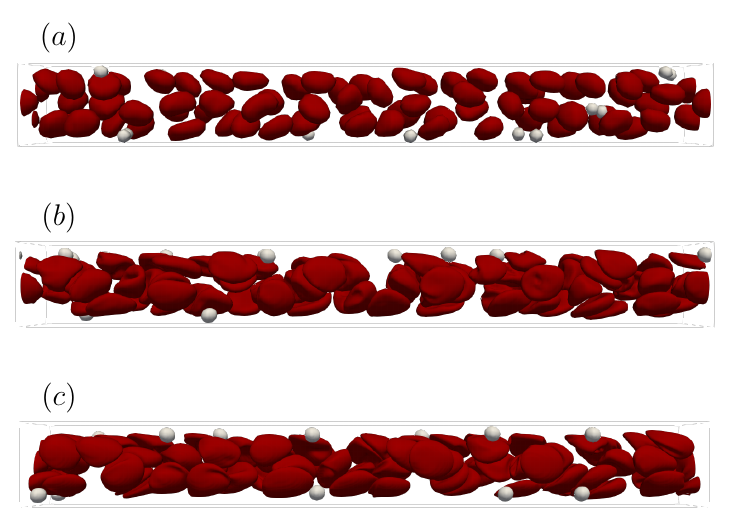
Figure A1. Snapshots of the simulation results in a straight channel of 96 × 16 × 16 µ m for ˙ γ w = 1228 s − 1 , Ht = 20%, platelet concentration = 0.5% at t = 1.0 s. ( a ) Spatial resolution ∆ x = D /16,